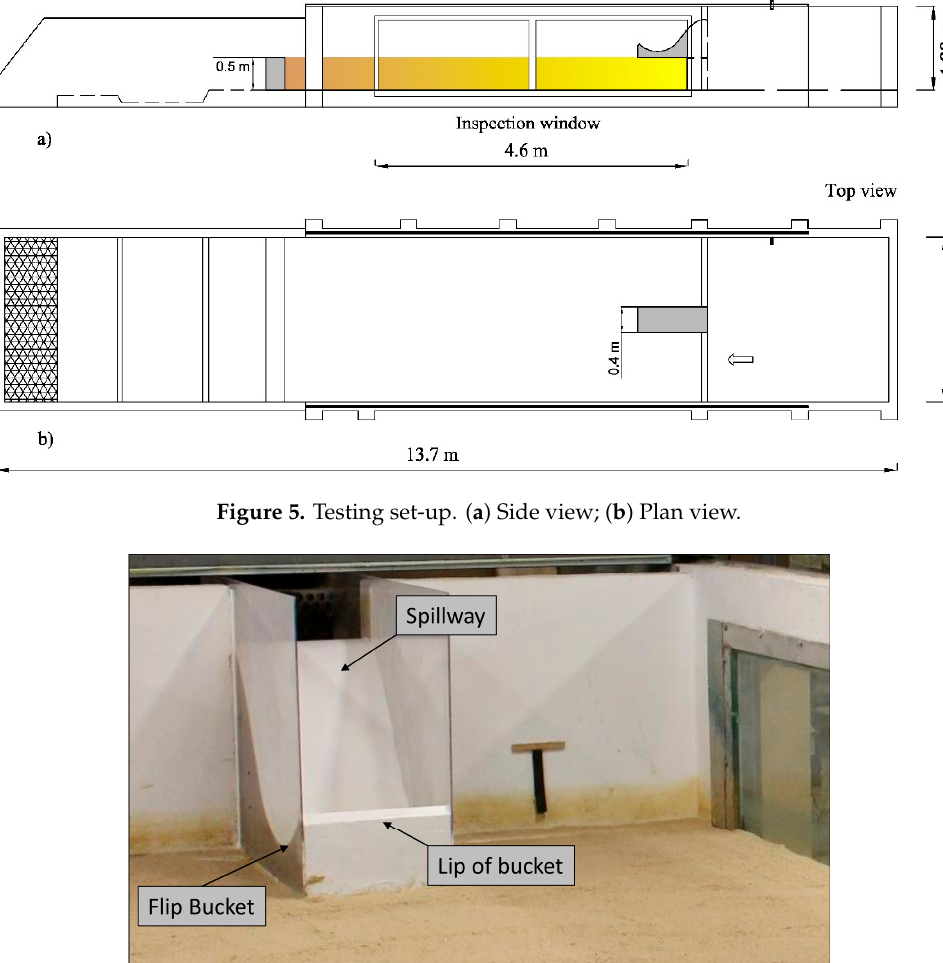
Figure 6. Sky-jump spillway in the testing channel. Case: radius of curvature 0.4 m; flip angle 45 ◦ .